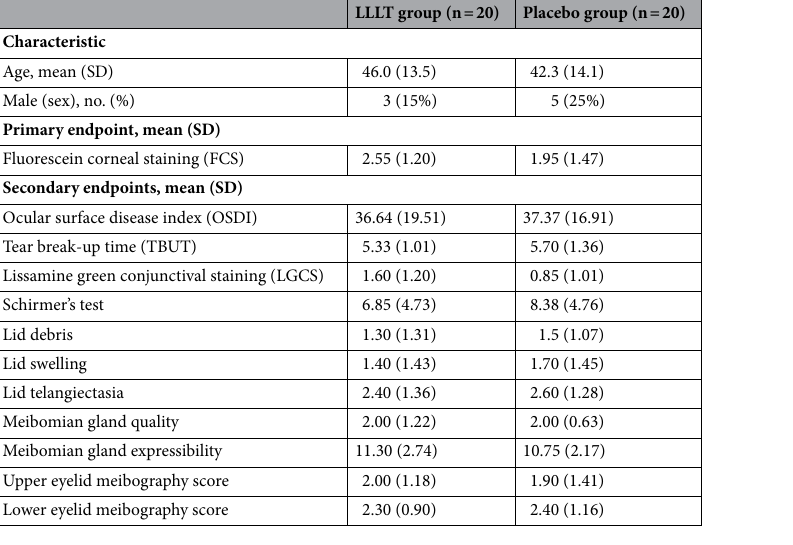
Table 1. Baseline demographic and clinical characteristics of each